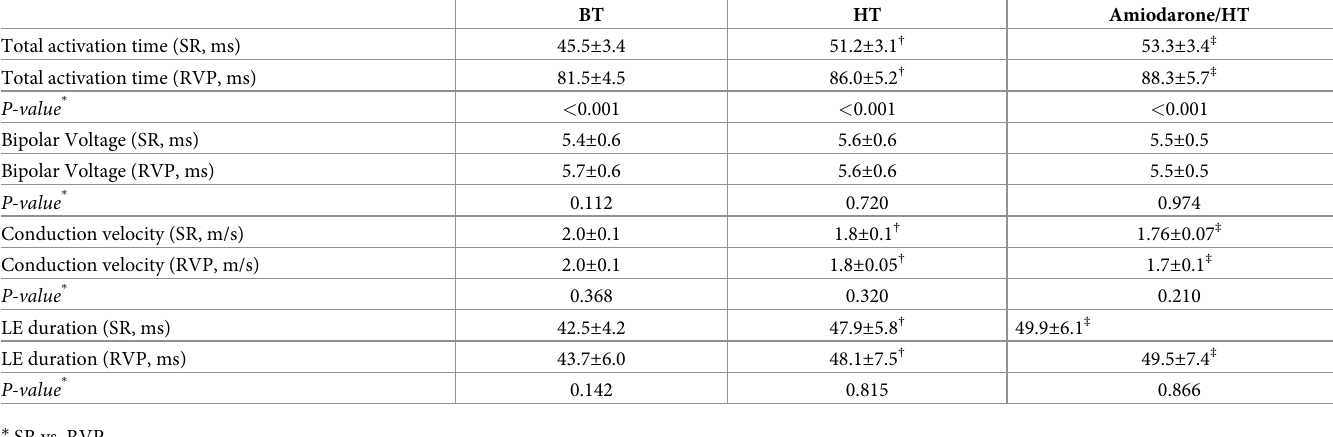
Table 1. Electrophysiological parameters of global ventricular epicardium.